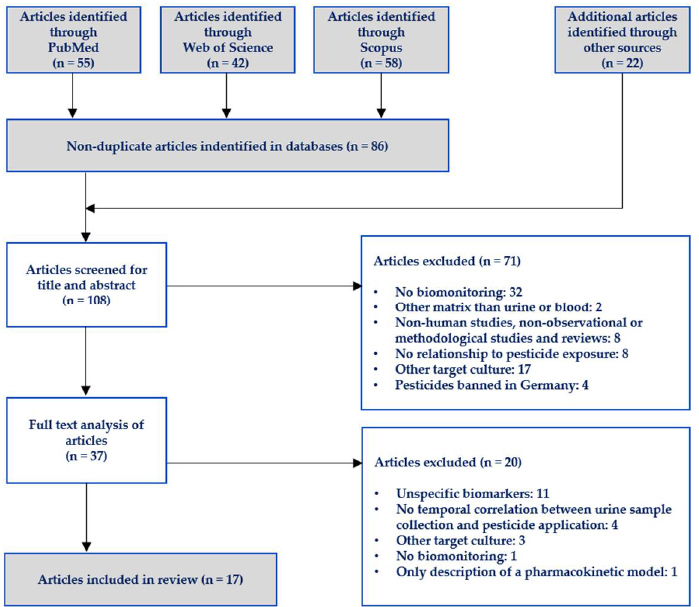
Figure 1. Flowchart of search strategy and study selection with exclusion criteria (based on [20]).